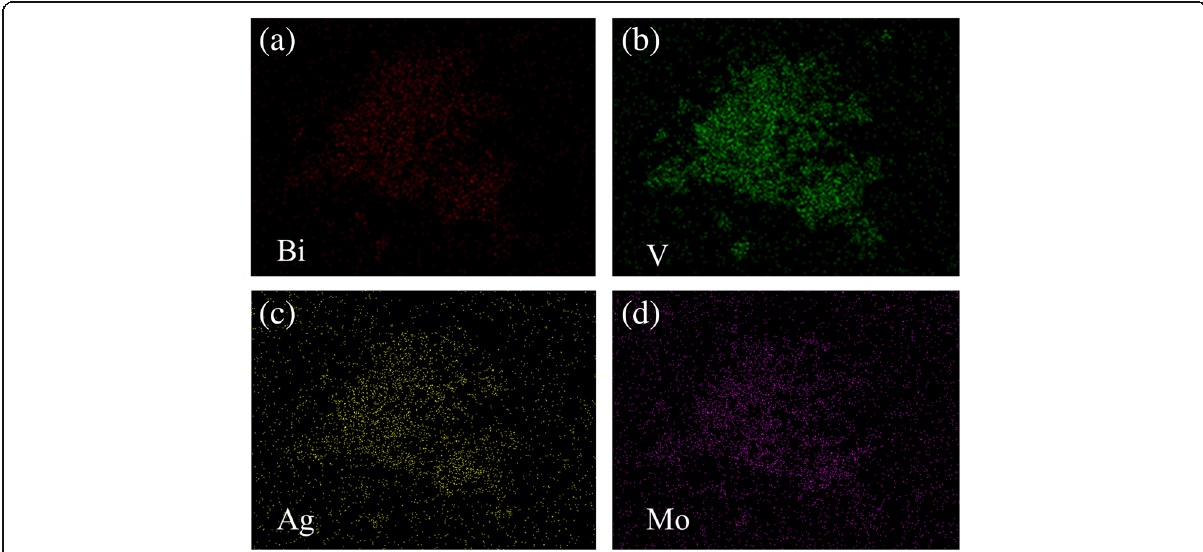
Fig. 2 a – d The corresponding elemental mapping analysis of Bi, V, Ag, and Mo in Ag/BiV 0.9925 Mo 0.0075 O 4 , respectively